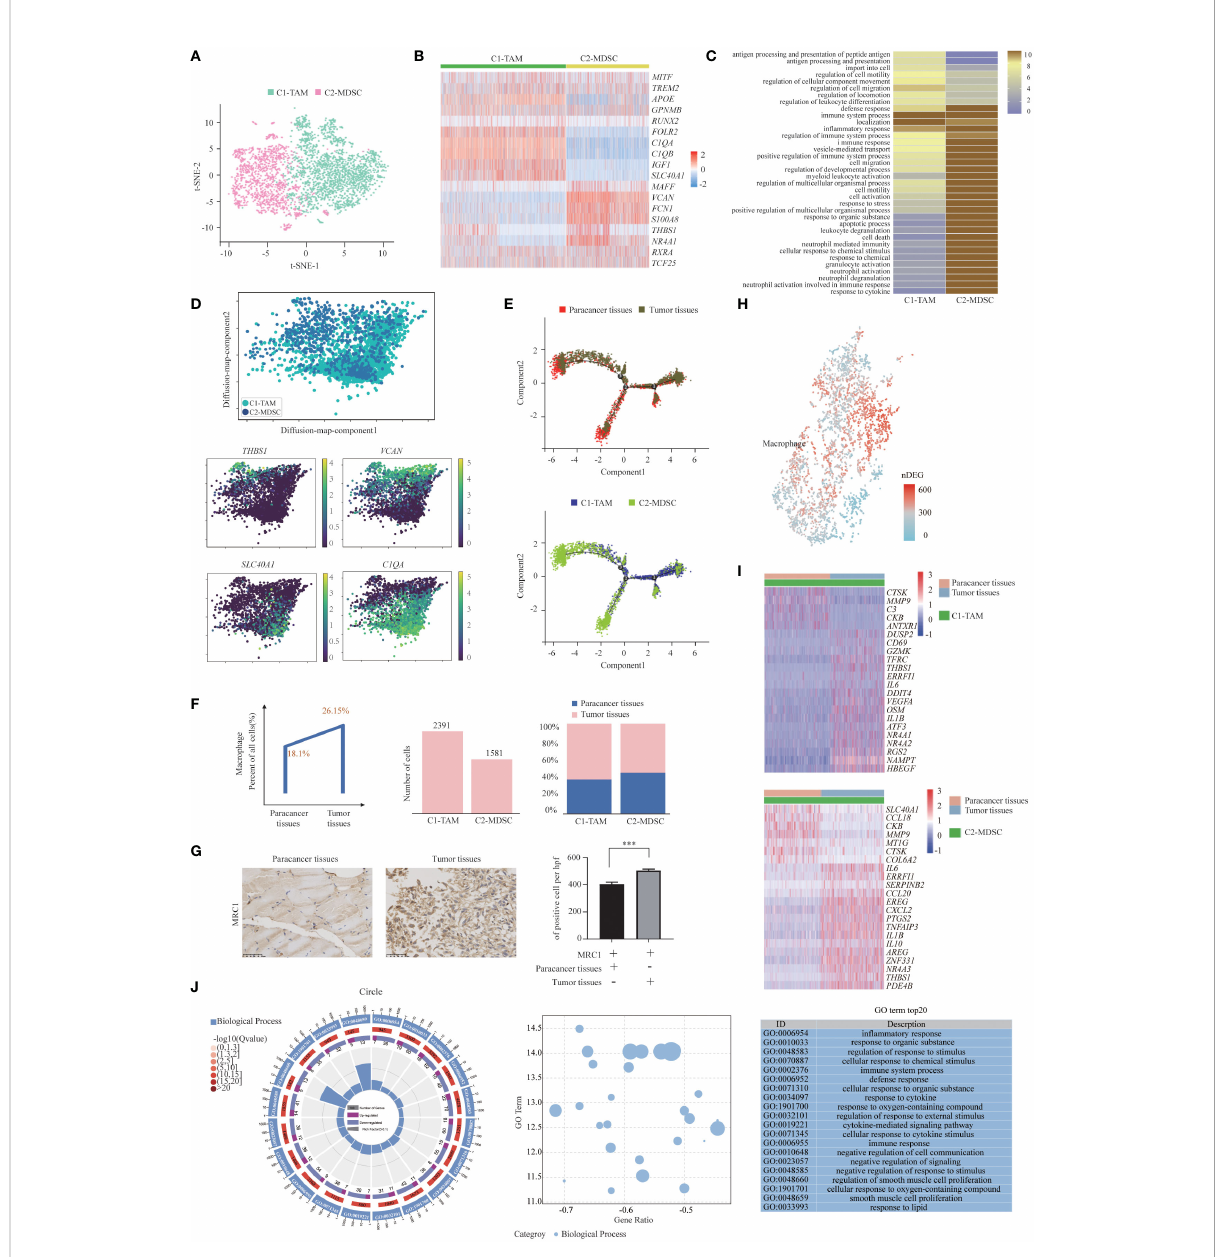
FIGURE 4 Two Distinct States of Tumor-Enriched Macrophages. (A) t-SNE plot showing the two main subsets of Macrophages. (B) Heatmap showing speci fi c marker genes in each Macrophages cluster. (C) Functional enrichment analysis of upregulated genes in each Macrophages cluster was performed with GO analysis. (D) Diffusion map showing the continuous connection of the two macrophage states (upper) and signature gene expression based on 10x (lower). (E) The Monocle 2 trajectory plot showed the dynamics of TAMs and MDSCs. (F) The percentages of Macrophages in paracancer tissues and tumor tissues (left). The cell number (middle) and proportion (right) of each cluster. (G) Immunohistochemistry of SUPS showed the expression of MRC1 in paracancer tissues and tumor tissues. Quanti fi cation of IHC staining from tumor tissues and paracancer tissues (n = 3) displayed as the average number of positive cells per high-powered fi eld (×200). Data are shown as the mean ± SEM. *** P < 0.001. (H) Number of DEGs between paracancer tissues and tumor tissues within Macrophages projected onto the t-SNE map. Number of DEGs between paracancer tissues and tumor tissues. DEG: |log fold change|>0.5, adjusted P <0.05 determined by Wilcoxon rank-sum test. (I) DEGs of TAMs and MDSCs in tumor tissues vs paracancer tissues in SUPS were analyzed. (J) GO term analysis of DEGs in Macrophages of tumor tissues versus paracancer tissues was performed. The fi rst lap indicates the top 20 GO terms and the number of the genes corresponds to the outer lap. The second lap indicates the number of genes in the genome background and Q values for enrichment of the upregulated genes for the speci fi ed biological process. The third lap indicates the ratio of the upregulated genes (deep purple) and downregulated genes (light purple). The fourth lap indicates the enrichment factor of each GO term. GO, gene